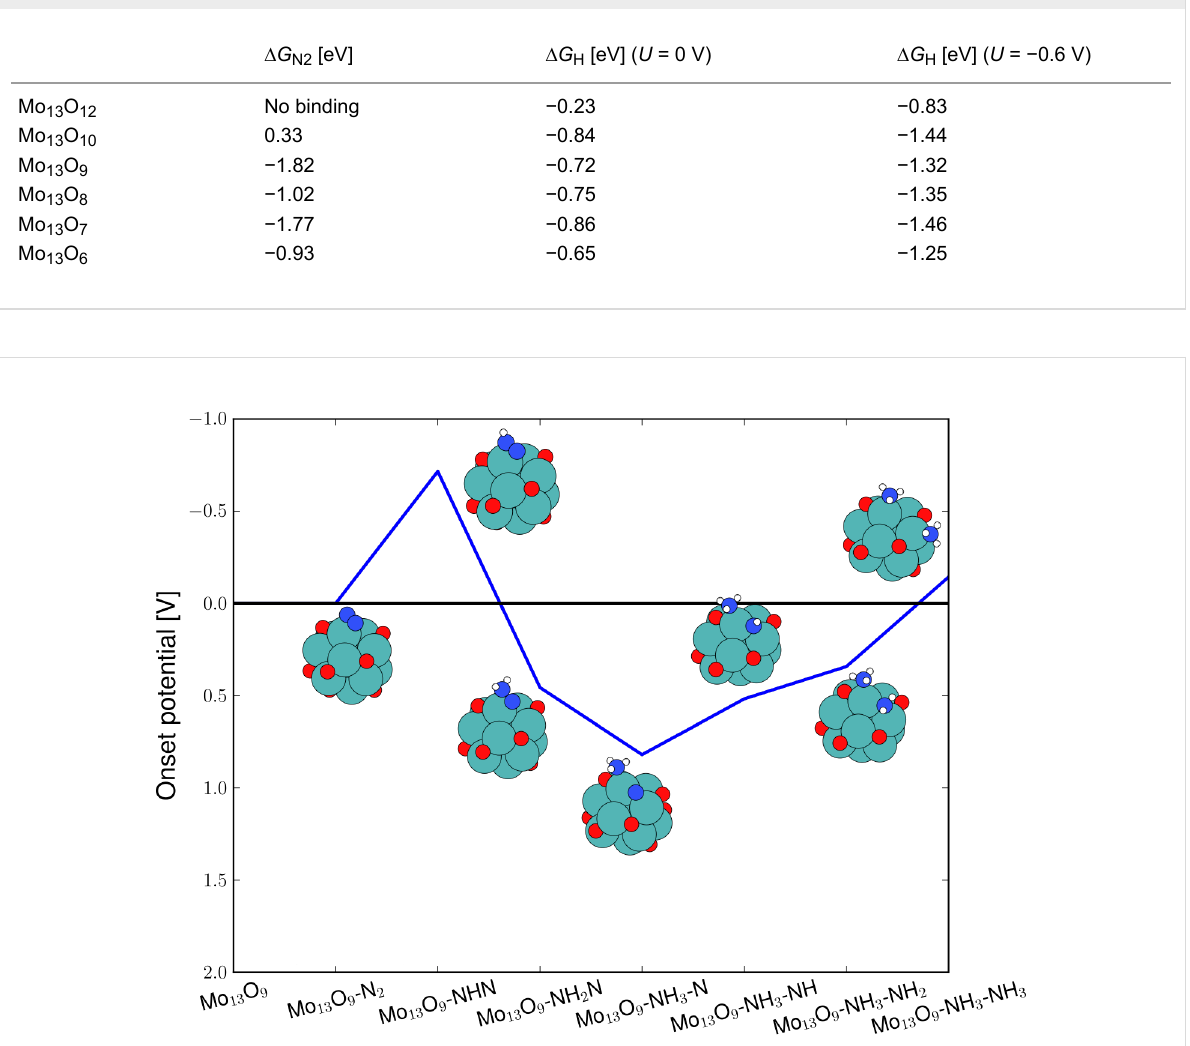
Table 4: The adsorption free energies of nitrogen and hydrogen with and without an applied potential on a partly oxygen covered Mo 13 nanocluster.